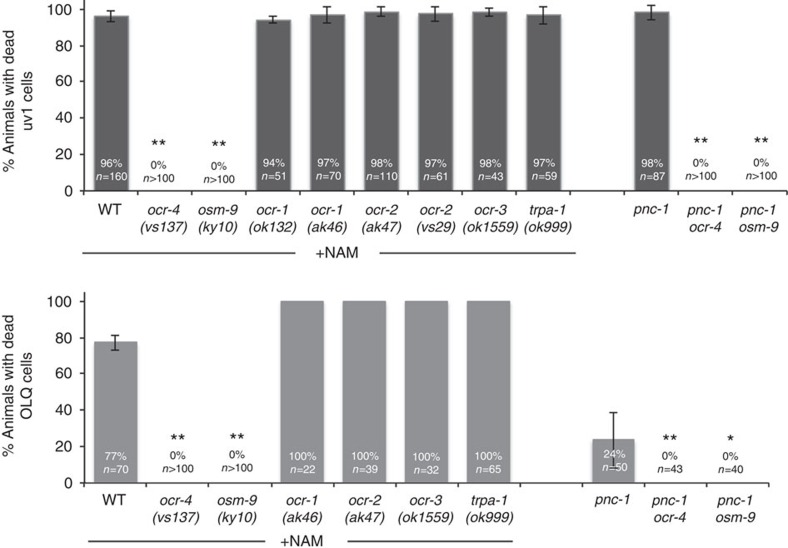
An OCR-4–OSM-9 TRPV channel mediates NAM-induced cell death.The percentage of animals with dead uv1 cells (black bars) or OLQ cells (grey bars) for each genotype supplemented with 25 mM NAM (+NAM) or in combination with pnc-1(pk9605) is reported. Actual percentages and sample sizes (n=number of animals examined) are indicated on each bar. Reported values for NAM supplemented animals are the average of at least three experiments and error bars are standard deviation. Error bars for the pnc-1 double mutant strains represent 95% confidence intervals of the proportion of the population (not applicable to values of 0 or 100%.) The wild-type strain used is N2. All alleles are loss or reduction of function with the exception of ocr-2(vs29) which is a dominant negative allele18. For statistical analysis, P values for all pairwise comparisons were calculated using Fisher's exact test followed by a Bonferroni correction considering eight (+NAM) or two (pnc-1) total pair-wise comparisons. ** Bonferroni adjusted P<0.001. * Bonferroni adjusted P=0.0018.